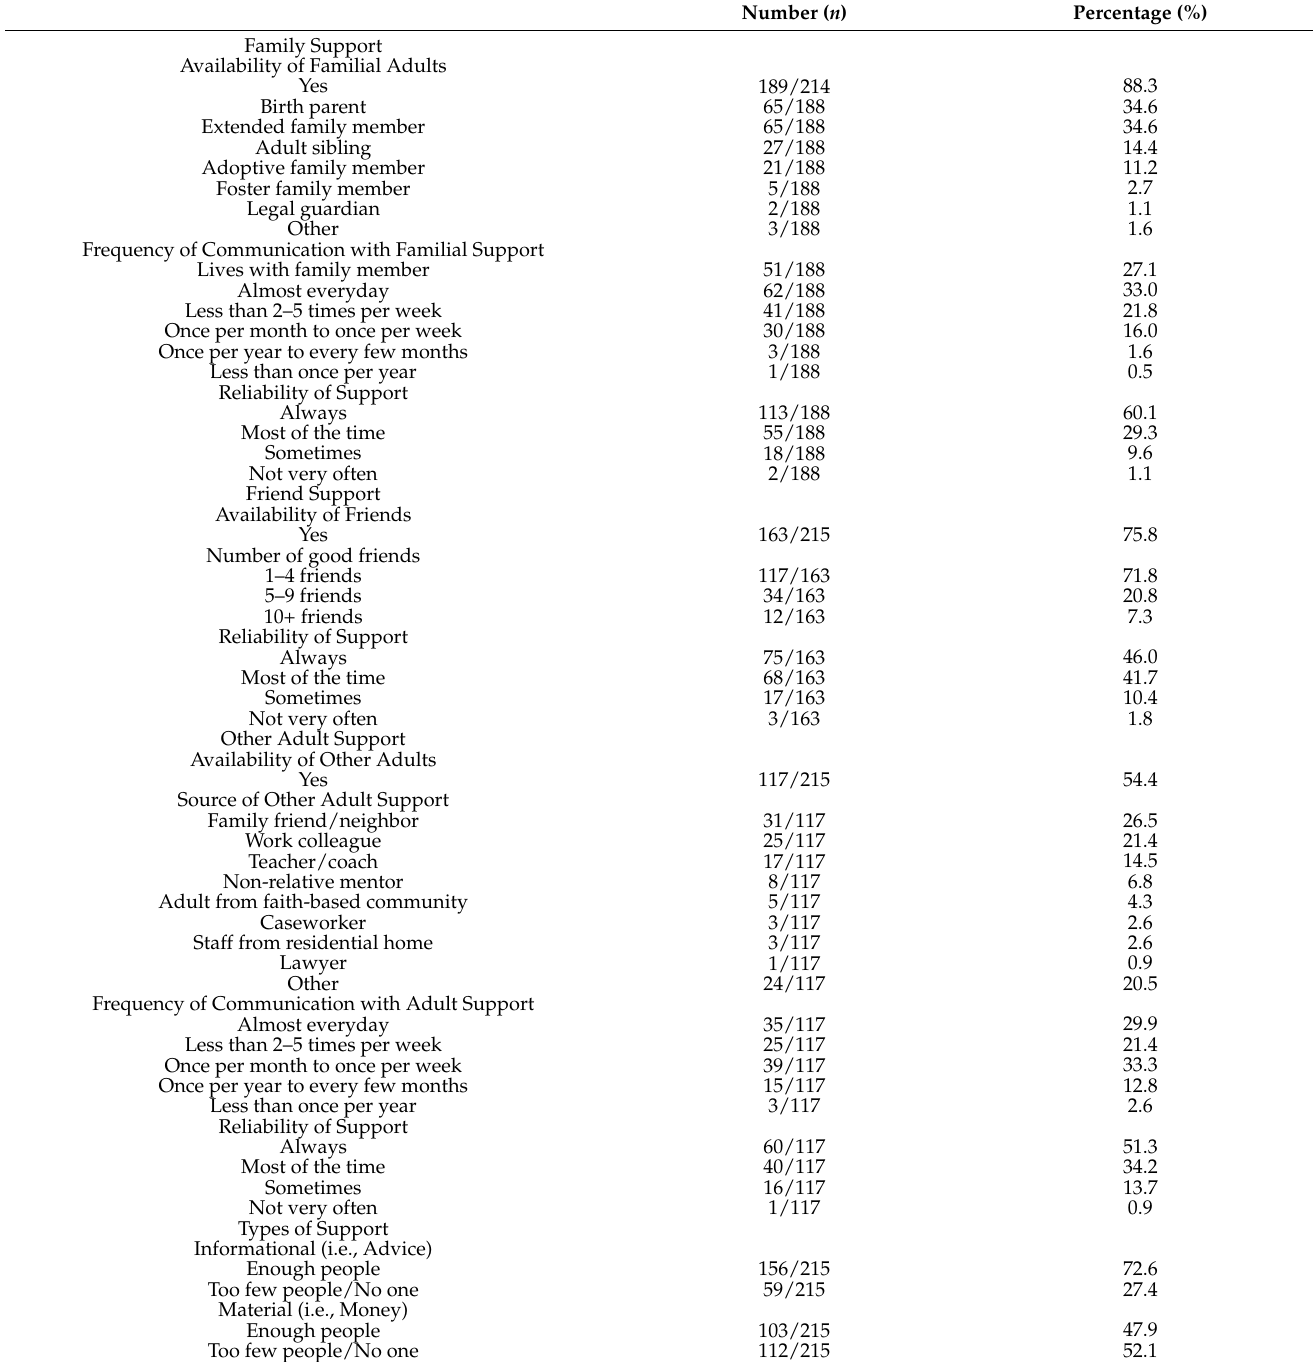
Table 1. Description of Source and Types of Social Supports ( n =